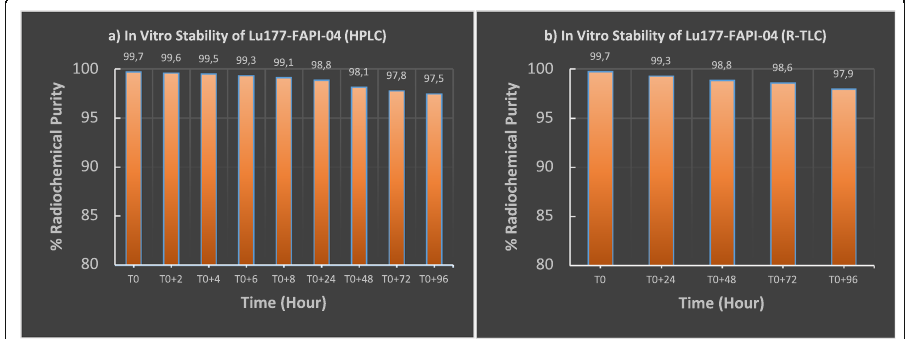
Fig. 6 Stability study of [ 177 Lu]Lu-FAPI-04. a Radiochemical purity results analyzed by R-HPLC: T0, T0 + 2 h, T0 + 4 h, T0 + 6 h, T0 + 8 h, T0 + 24 h, T0 + 48 h, T0 + 72 h, T0 + 96 h. b Radiochemical purity results analyzed by R-TLC: T0, T0 + 24 h, T0 + 48 h, T0 + 72 h, T0 + 96 h . (T0 = End of the